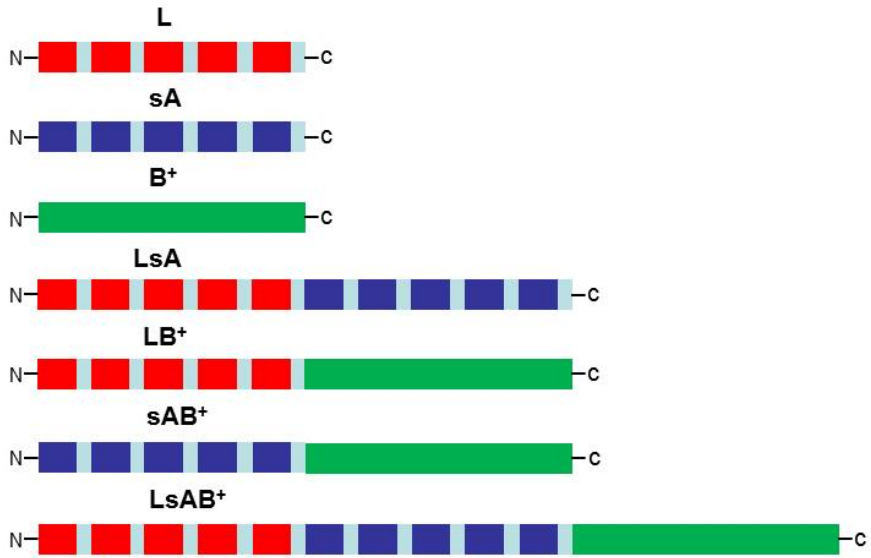
Figure 2. Schematic representation of the different combinations of CHIKV E2 protein fragments. Red: neutralizing epitope; dark blue: surface exposed domains of A; green: domain B with β -ribbon connector; light blue: G-S linker.